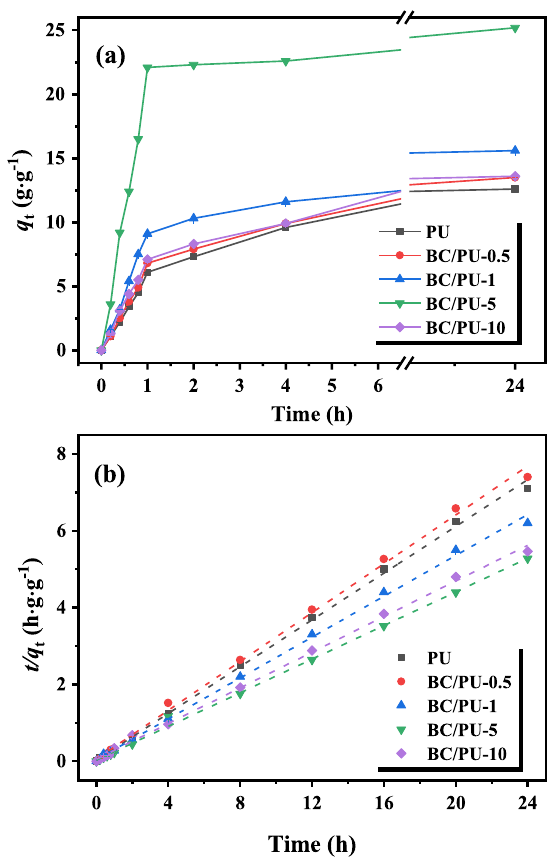
t ) ( a ) and plots of